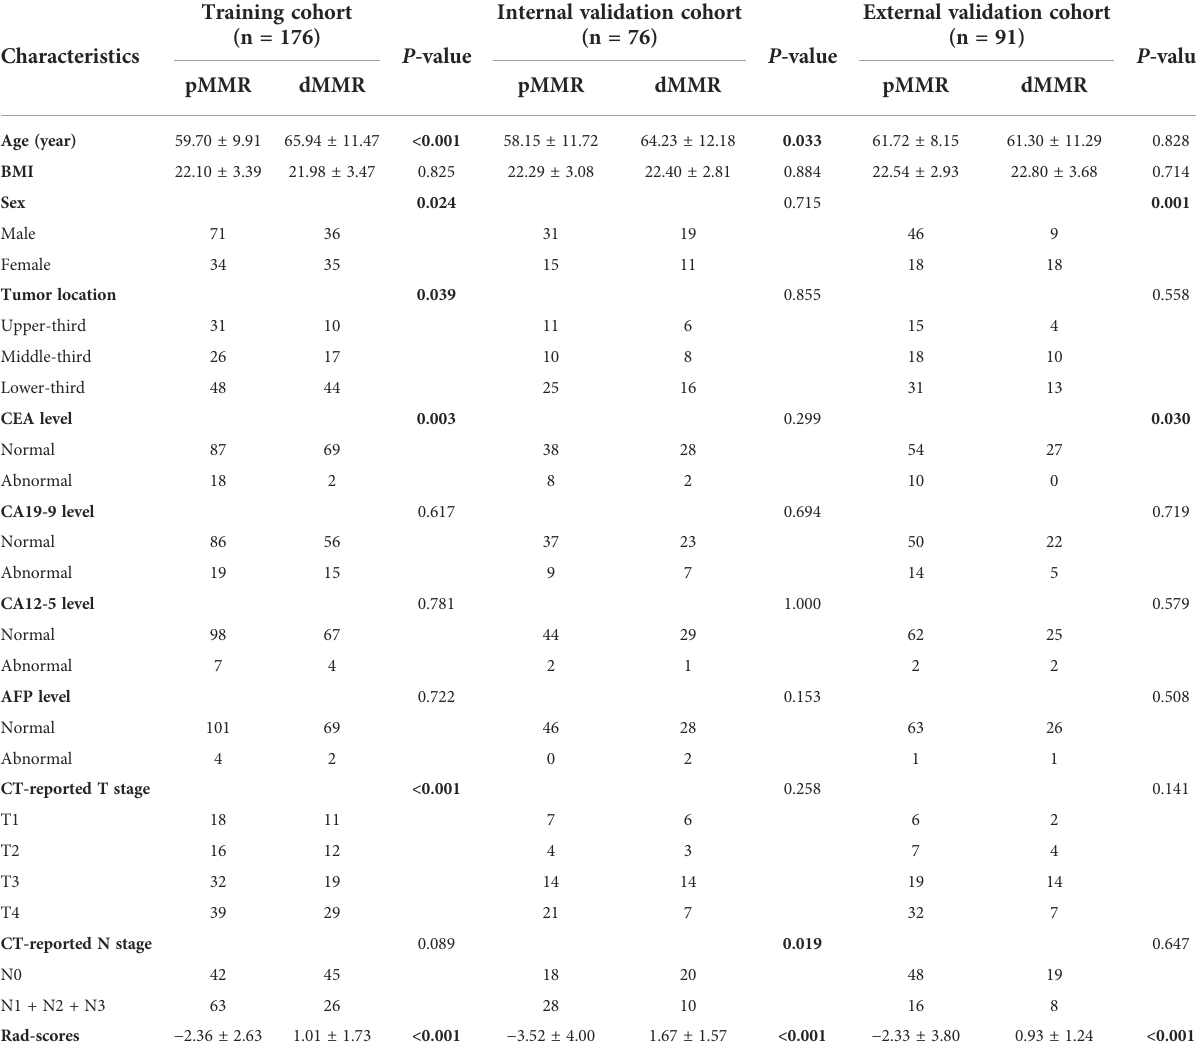
TABLE 1 Characteristics of GC patients in training, internal validation and external validation cohorts.